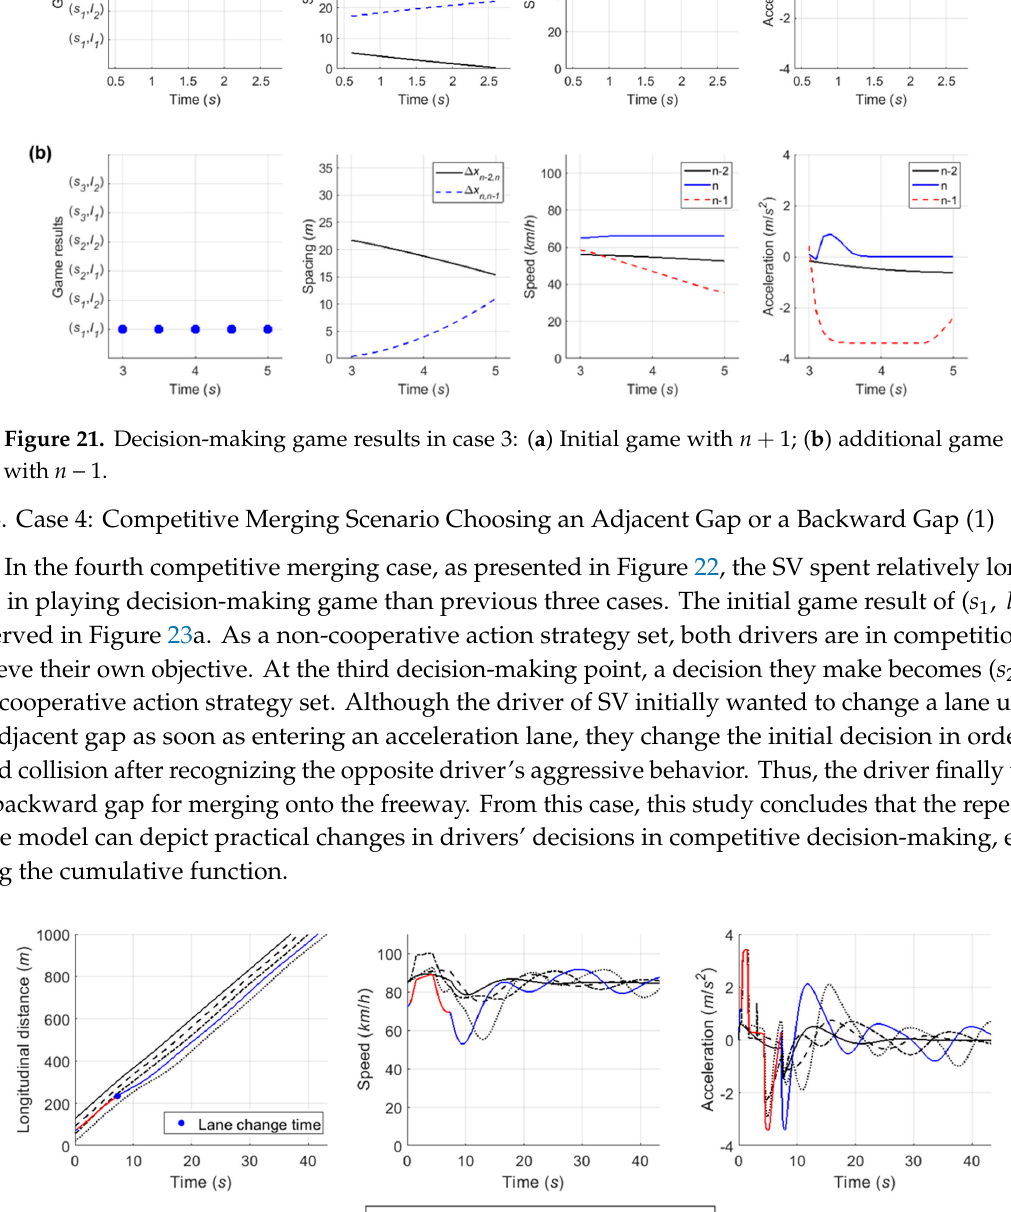
Figure 20. Graphical representation of simulation results in case 3.